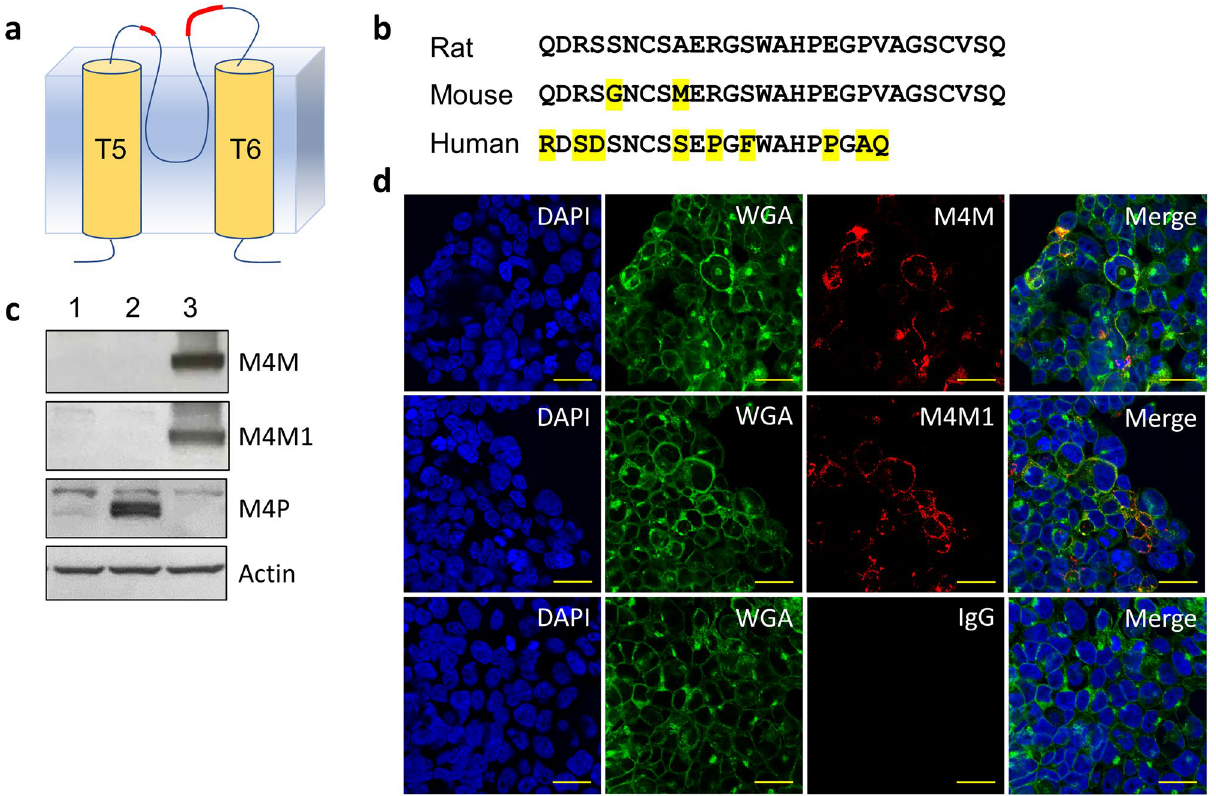
Figure 1. Generation of monoclonal antibody against human TRPM4 channel. ( a ) The extracellular antigenic epitope RDSDSNCSSEPGFWAHPPGAQ (labelled in red) is located close to the human TRPM4 channel pore. ( b ) Alignment of the antigenic sequences from rat and human TRPM4 channels for generating polyclonal antibody M4P against rat TRPM4 and monoclonal antibody against human TRPM4. Mouse sequence was also demonstrated for comparison. Residues different from rat sequence were highlighted in yellow. ( c ) Western blot on HEK 293 cells transfected with pcDNA c-Myc empty vector (lane 1), mouse TRPM4 (lane 2) and human TRPM4 (lane 3). M4M and M4M1 are two mouse monoclonal antibodies raised against human TRPM4. M4P is a polyclonal antibody raised against rodent TRPM4. Full-length blots are presented in Supplementary Fig. S1. ( d ) Live human TRPM4 expressing HEK 293 cells were incubated with M4M, M4M1 or control mouse IgG at a concentration of 0.4 µg/mL for 1 h, followed by fixation and staining with secondary antibody against mouse IgG. Cell membrane was labeled with Wheat Germ Agglutinin (WGA). Scale bars: 20